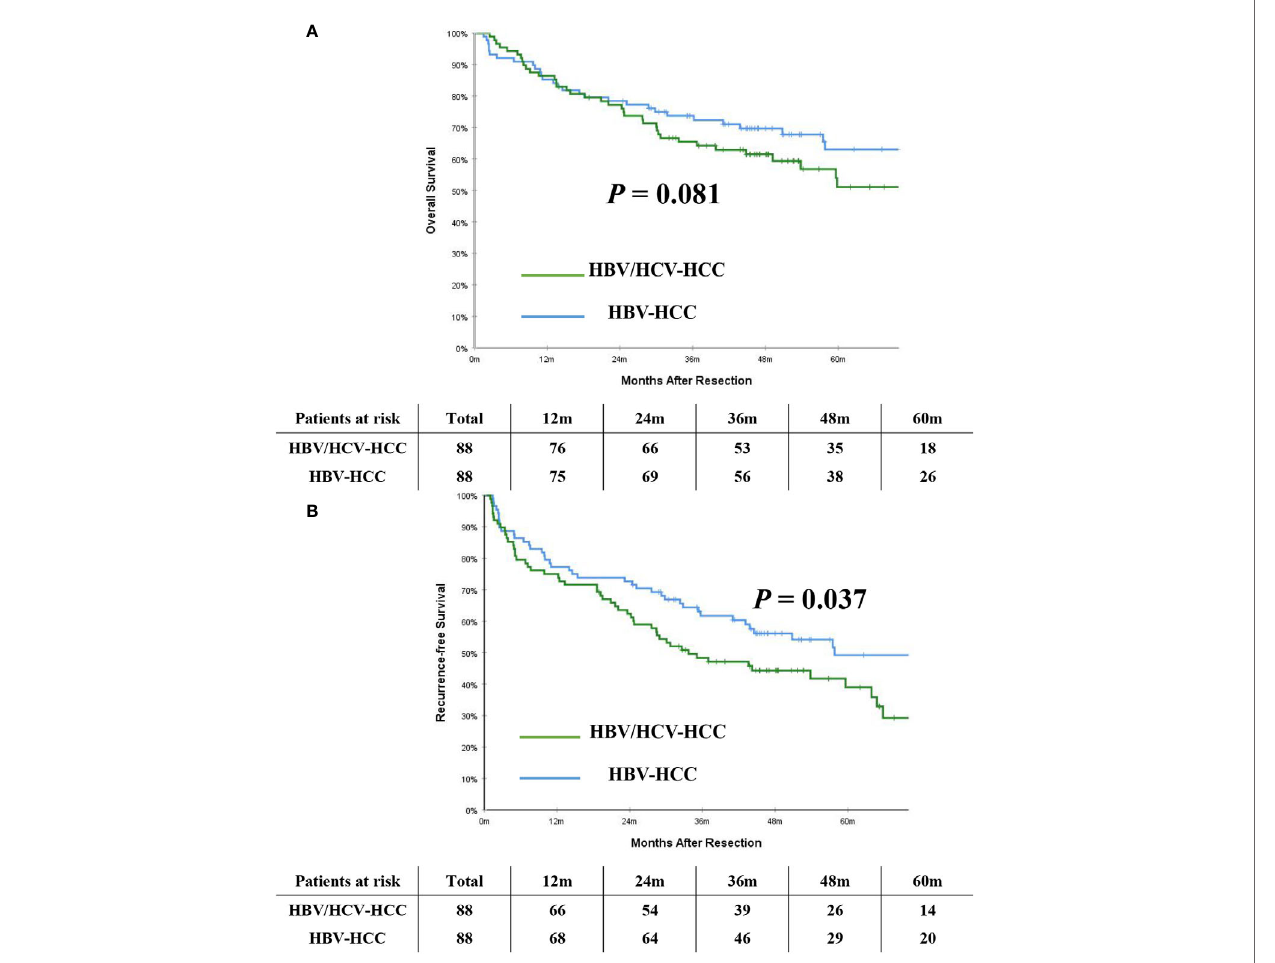
FIGURE 3 | Kaplan-Meier curves of overall survival (A) and recurrence-free survival (B) between patients with HBV/HCV-HCC and HBV-HCC in the propensity score matching cohort.